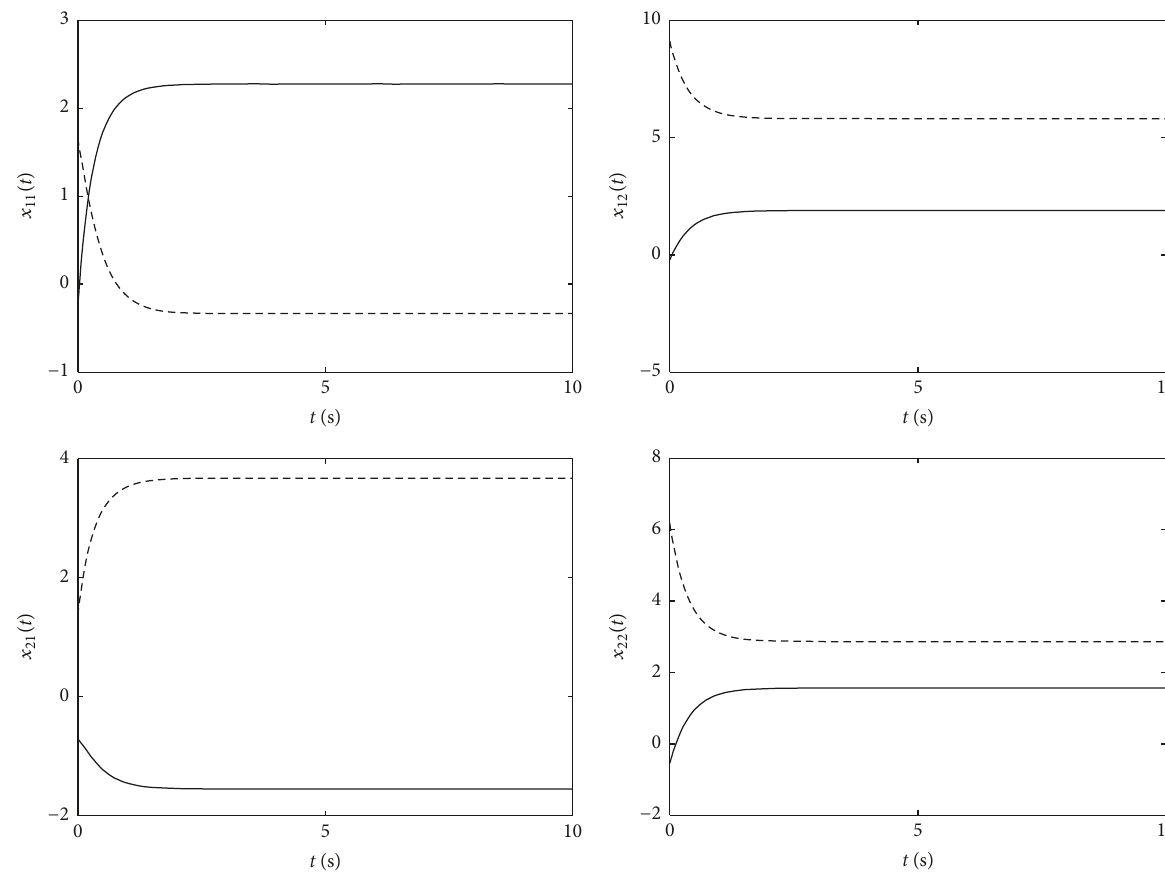
Figure3:Trajectoriesofstatematrix 𝑋(𝑡) ∈ 𝑅 2×2 forsolvingGLME(27)withthemultipletheoreticalsolutions 𝑋 ∗ ,startingfromtwodifferent initial states 𝑋(0) ∈ 𝑅 2×2 .